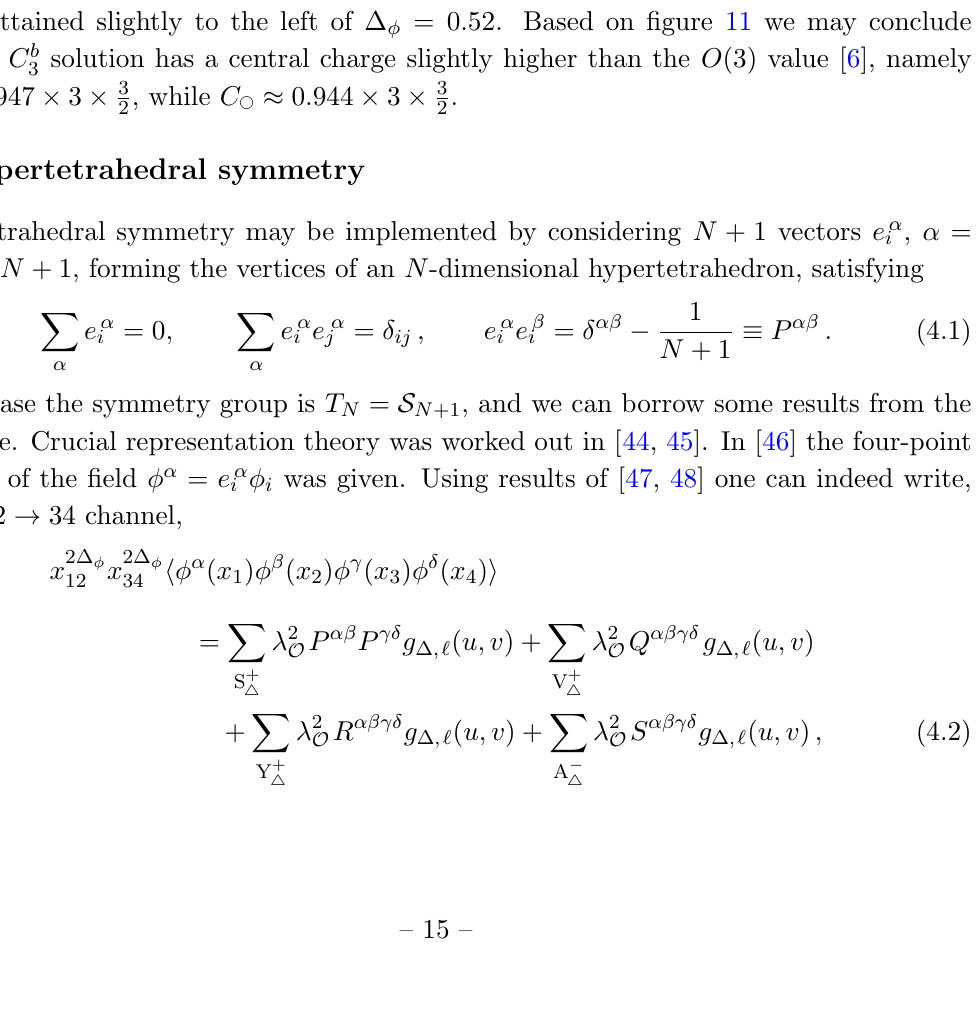
solution as a function of the dimension of (cid:30) 3